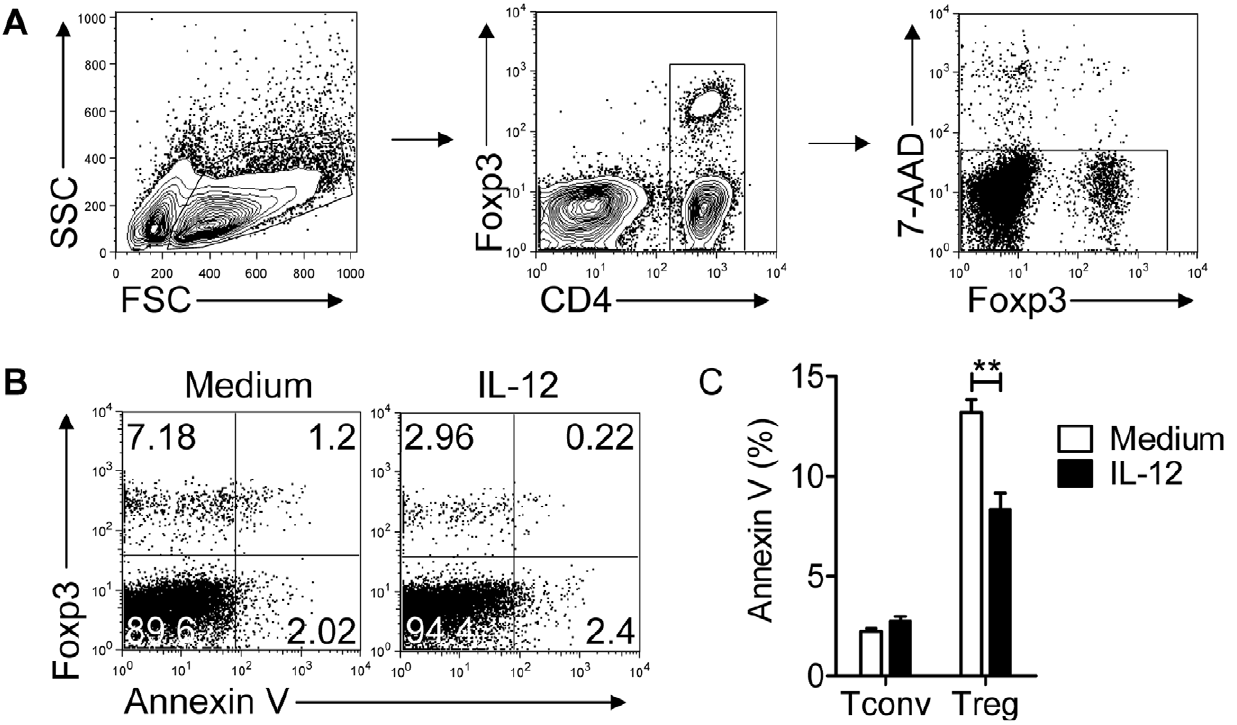
Figure 6. IL-12 does not induce apoptosis in Tconvs or Tregs. Lymphocytes were prepared from Foxp3 gfp mice and cultured in the presence of anti-CD3 mAb with or without IL-12 for 72 hr. (A) Gating strategy to identify live CD4 T cells is shown. (B) Representative FACS plots are shown. (C) Summary of data from 3 independent experiments, each performed in triplicate, is shown. *** P , 0.01, Student’s two-tailed un-paired t tests.